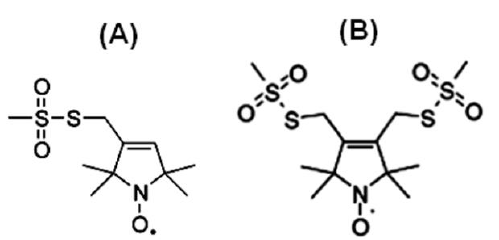
Figure 2. Structure of examples of nitroxide spin labels used in the site-directed spin labeling (SDSL) EPR study of membrane proteins. ( A ) Methanethiosulfonate spin label (MTSL), ( B ) Bifunctional spin label (BSL).